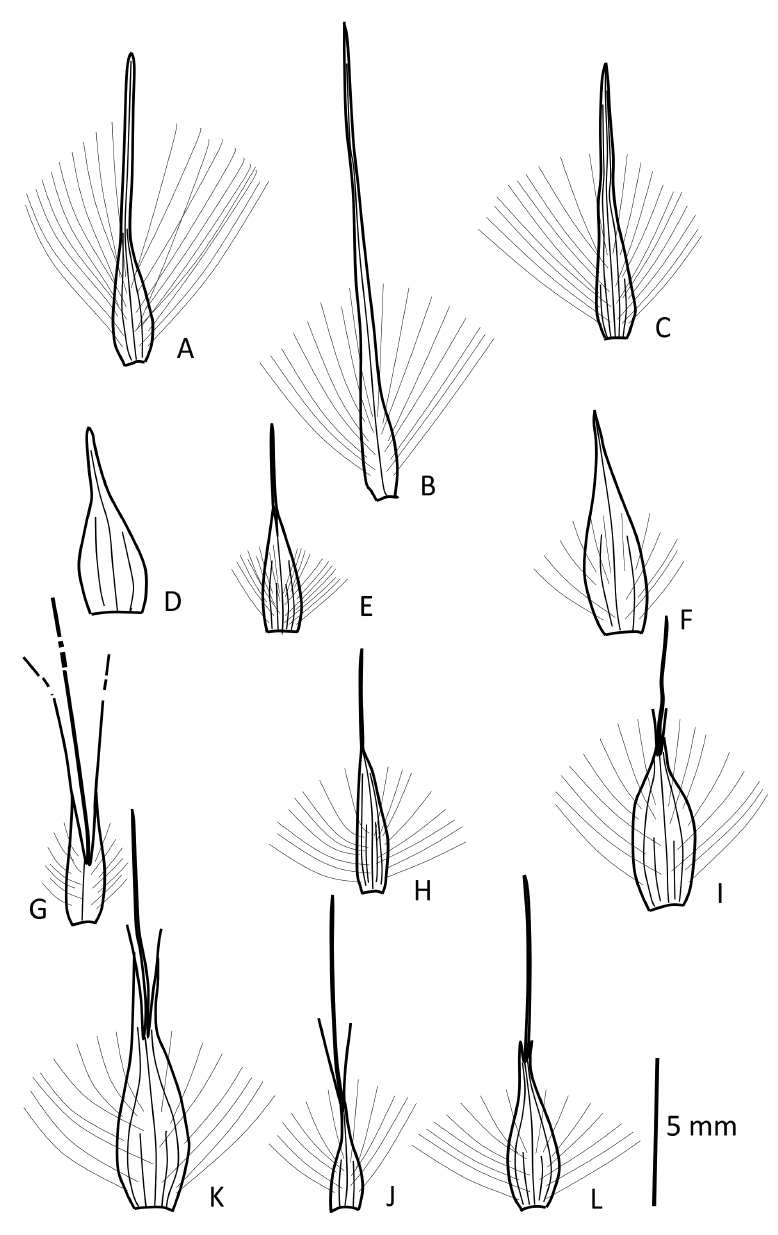
Figure 1. Lemmas of selected species of Cortaderia . A C. selloana , Jürgens 40 (B) B C. araucana , Borchers s.n. (US) C C. speciosa , P.M. Peterson 12766 (US) D C. vaginata, L.B. Smith, P.R. Reitz & R. Klein 7761 (B) E C. egmontiana, P.M. Peterson, R.J. Soreng & N. Refulio-Rodriguez 17508 (US) F C. modesta, A. Chase 8288 (US) G C. hieronymi, A. Burkart et al. 30395 (P) – note that awn and setae are much longer than illustrated H C. nitida, S. Laegaard 52786 (K) I C. sericantha, E. Asplund 17175 (B) J C. bifida, D.N. Smith & J. Cabanillas 7167 (US) K C. hapalotricha, J.C. Solomon & R. Chevalier 16620 L C. columbiana, J.P. Schulz 318 (US). All at same